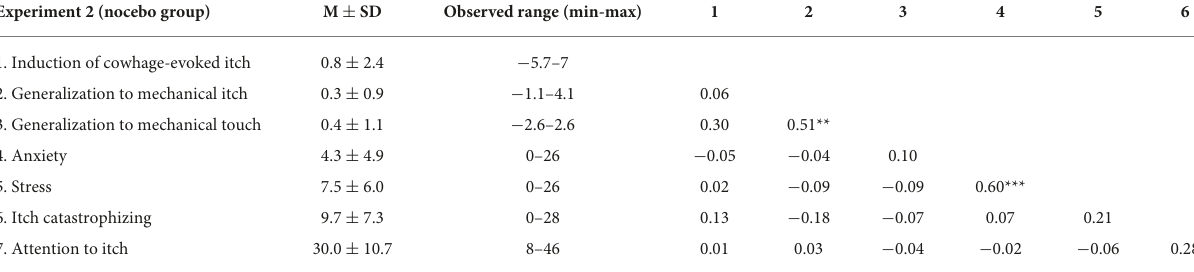
TABLE 2 Mean (M) ± SD and intercorrelations of predictors and dependent outcomes in experiment 2 ( n = 44). Experiment 2 (nocebo group) M ±